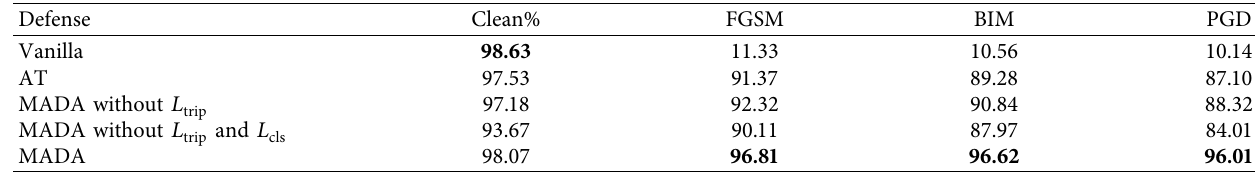
Table 3: Accuracy results on MNIST.